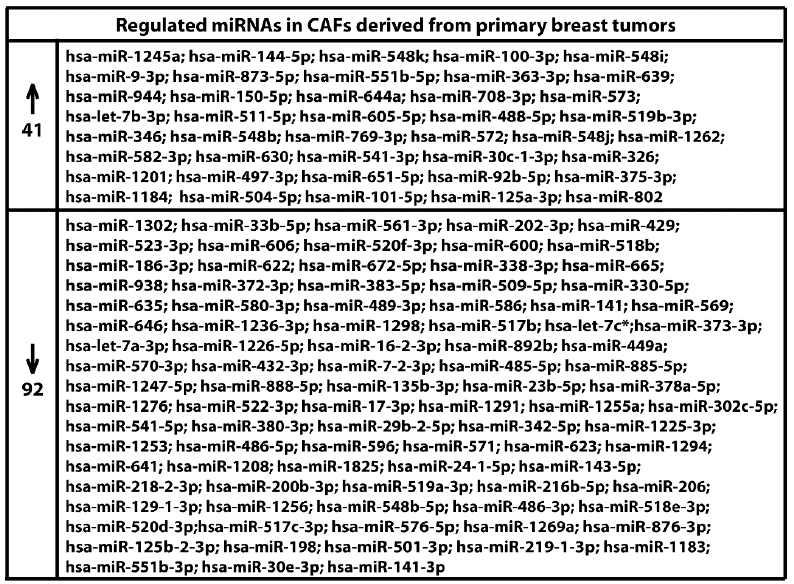
Figure 6. Identification of up ( n = 41) and down ( n = 92) regulated miRNAs in CAFs derived from primary breast tumors and treated for 4 h with 100 nM E2.